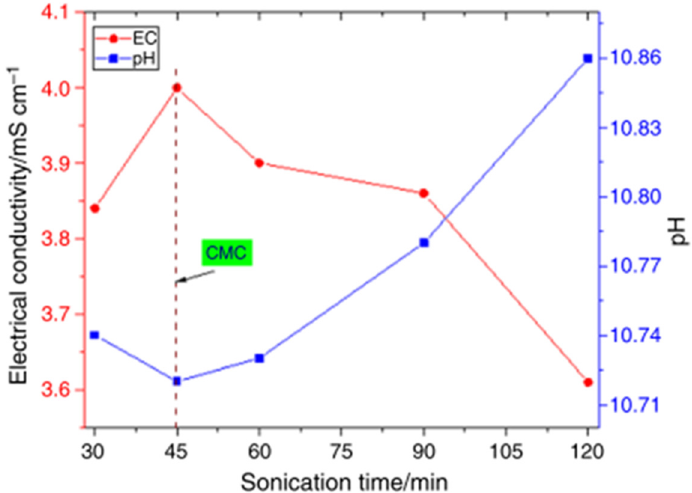
Figure 21. Effect of sonication time on electrical conductivity and pH of 0.5 vol% MgO-ZnO/DIW NF. Adapted from [77].